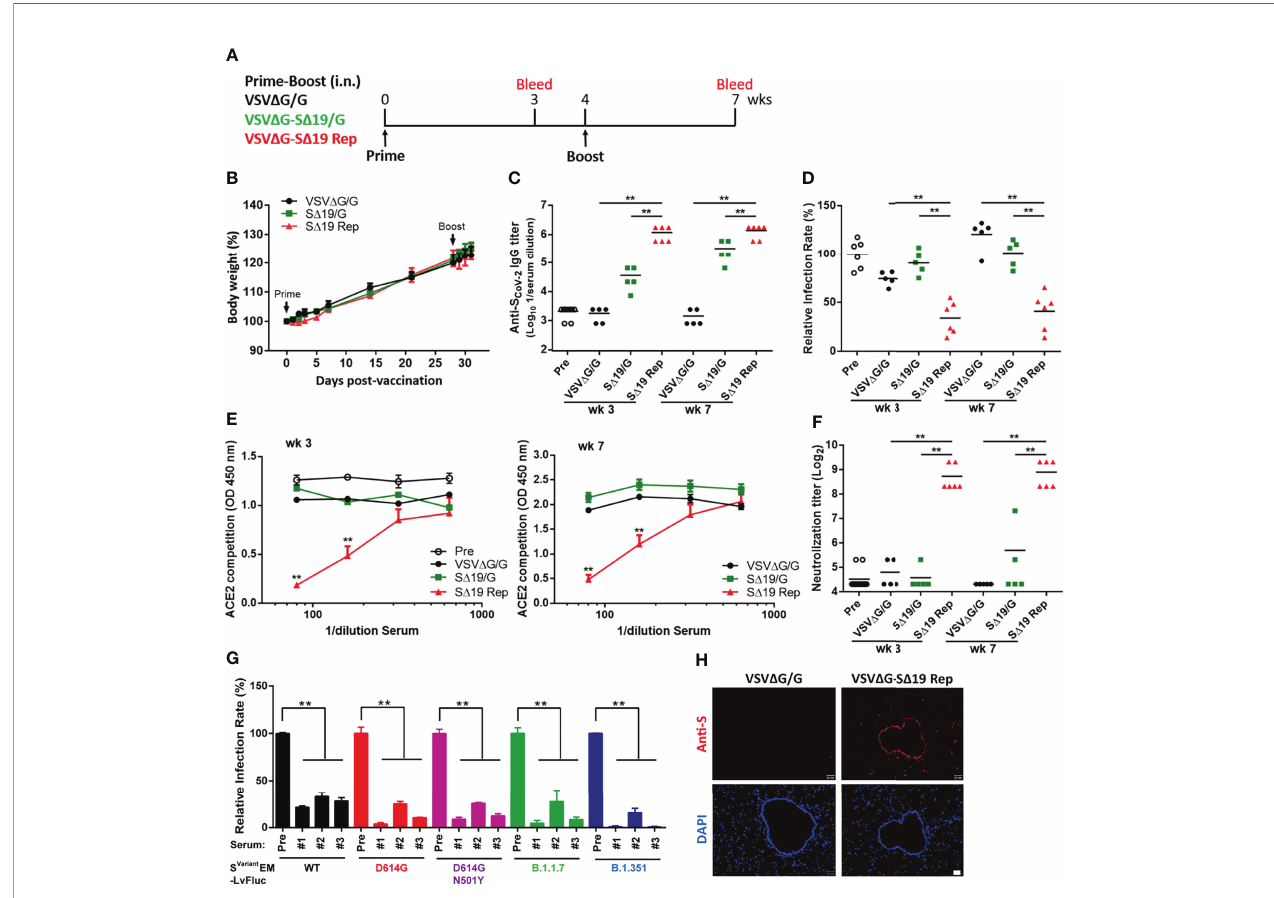
FIGURE 2 | TheS D 19 Rep virus effectively stimulates anti-spikeantibodies with neutralizingactivity in hamsters. (A) Experimentaldesign of the prime-boost vaccination with VSV D G/G (control virus), VSV D G-S D 19/G (replication-incompetent virus), and S D 19 Rep inGold Syrian hamster by intranasal(i.n.) administration (1×10 6 pfu or ffu/hamster; n=5-6).Body weight of vaccinated hamsterswas monitored periodically (B) . Serum samples collected from 3 and 7 weekspost-vaccination were subjected to ELISA for anti-spike speci fi c IgG antibody (C) , the VSV D G-Spikepseudovirus-based neutralization assay (D) , the RBD-hACE2 interaction competition assay (E) , the SARS-CoV-2 neutralization assay (F) , and the the S variant EM-LvFluc viruses-based neutralization assay (G) . (H) Lungsectionsobtained fromhamstersinfected with VSV D G/G or S D 19 Rep (1×10 6 pfu orffu/hamster;i.n.) at 20 hrspost-infection were stained with anti-S antibodies andcounterstained with DAPI. **P < 0.01. Scalebar:20 m